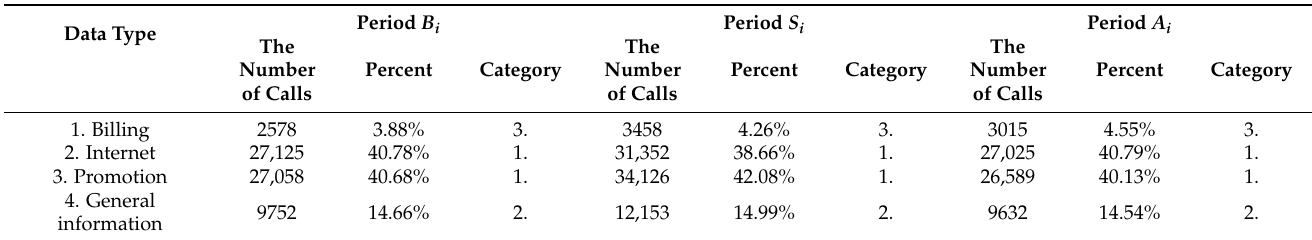
Table 8. The classifications for data type 1.